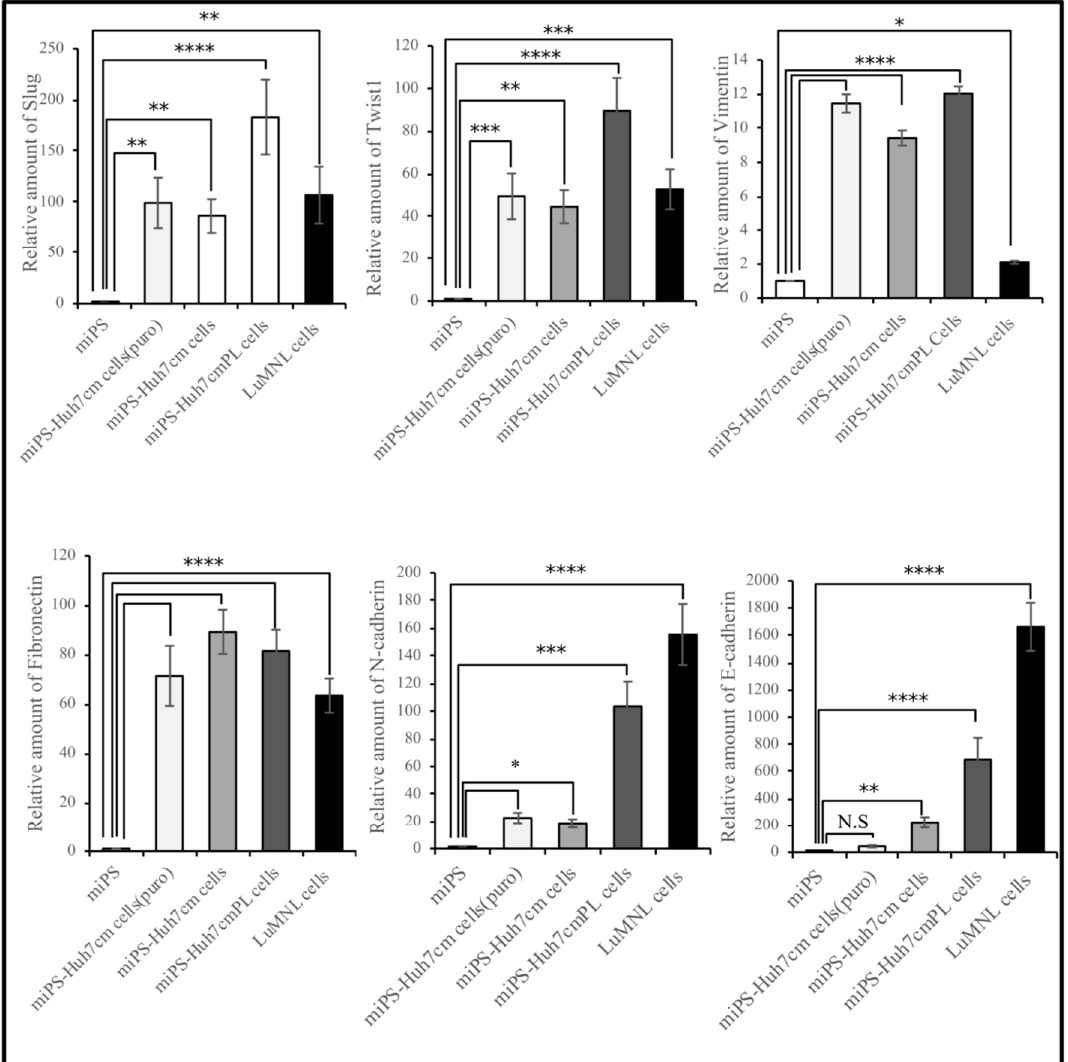
Figure 5. Real-time-qPCR analysis of metastatic markers (Slug and Twist1), mesenchymal markers (Vimentin, N-cadherin and fibronectin) and the epithelial marker (E-cadherin) in cells derived from intrahepatic transplantation (miPS-Huh7cmPL cells and LuMNL cells) in comparison with miPS-Huh7cm cells, miPS-Huh7cm cells (Puro) and miPSCs (* p < 0.01, ** p < 0.001, *** p < 0.0001, **** p < 0.00001).